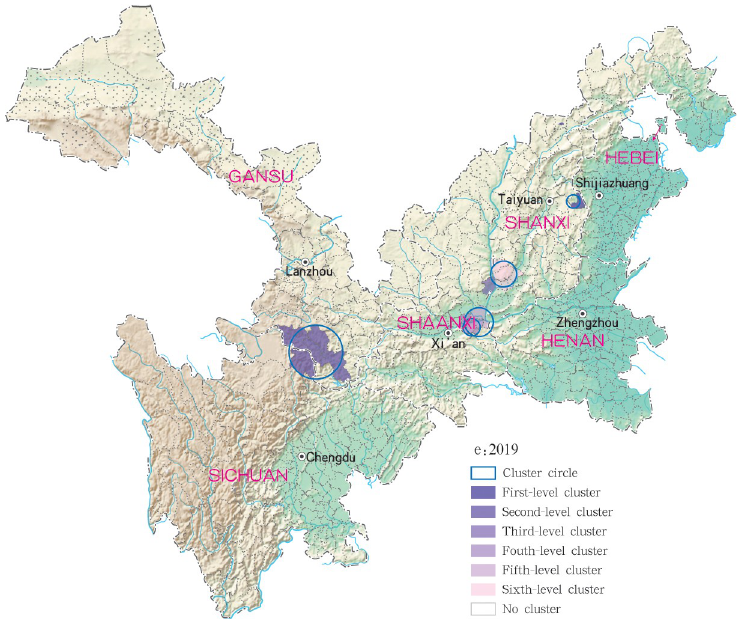
Fig 15. Spatio-temporal clustering analysis of mountain-type zoonotic visceral leishmaniasis incidence in 6 provinces, China in 2019.